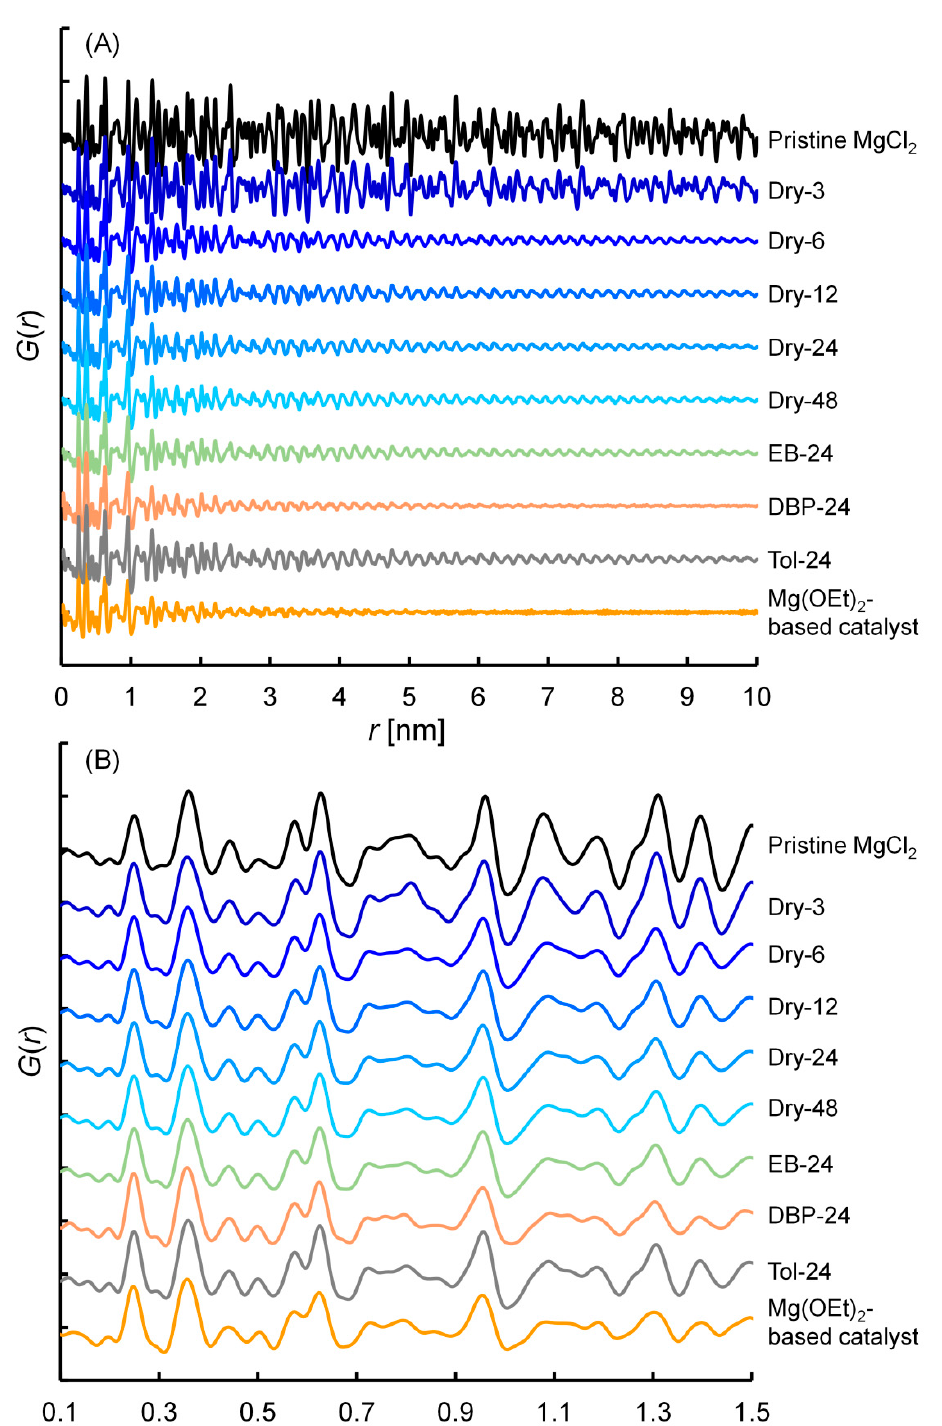
Figure 2. Atomic pair distribution functions (PDFs) of mechanically activated MgCl 2 samples. Long-range and short-range regions are separately represented in panels ( A , B ). The sample names exhibit the grinding condition, the type of additives and grinding duration in hours. Mg(OEt) 2 -based catalyst is a typical example of chemically activated δ -MgCl 2 .